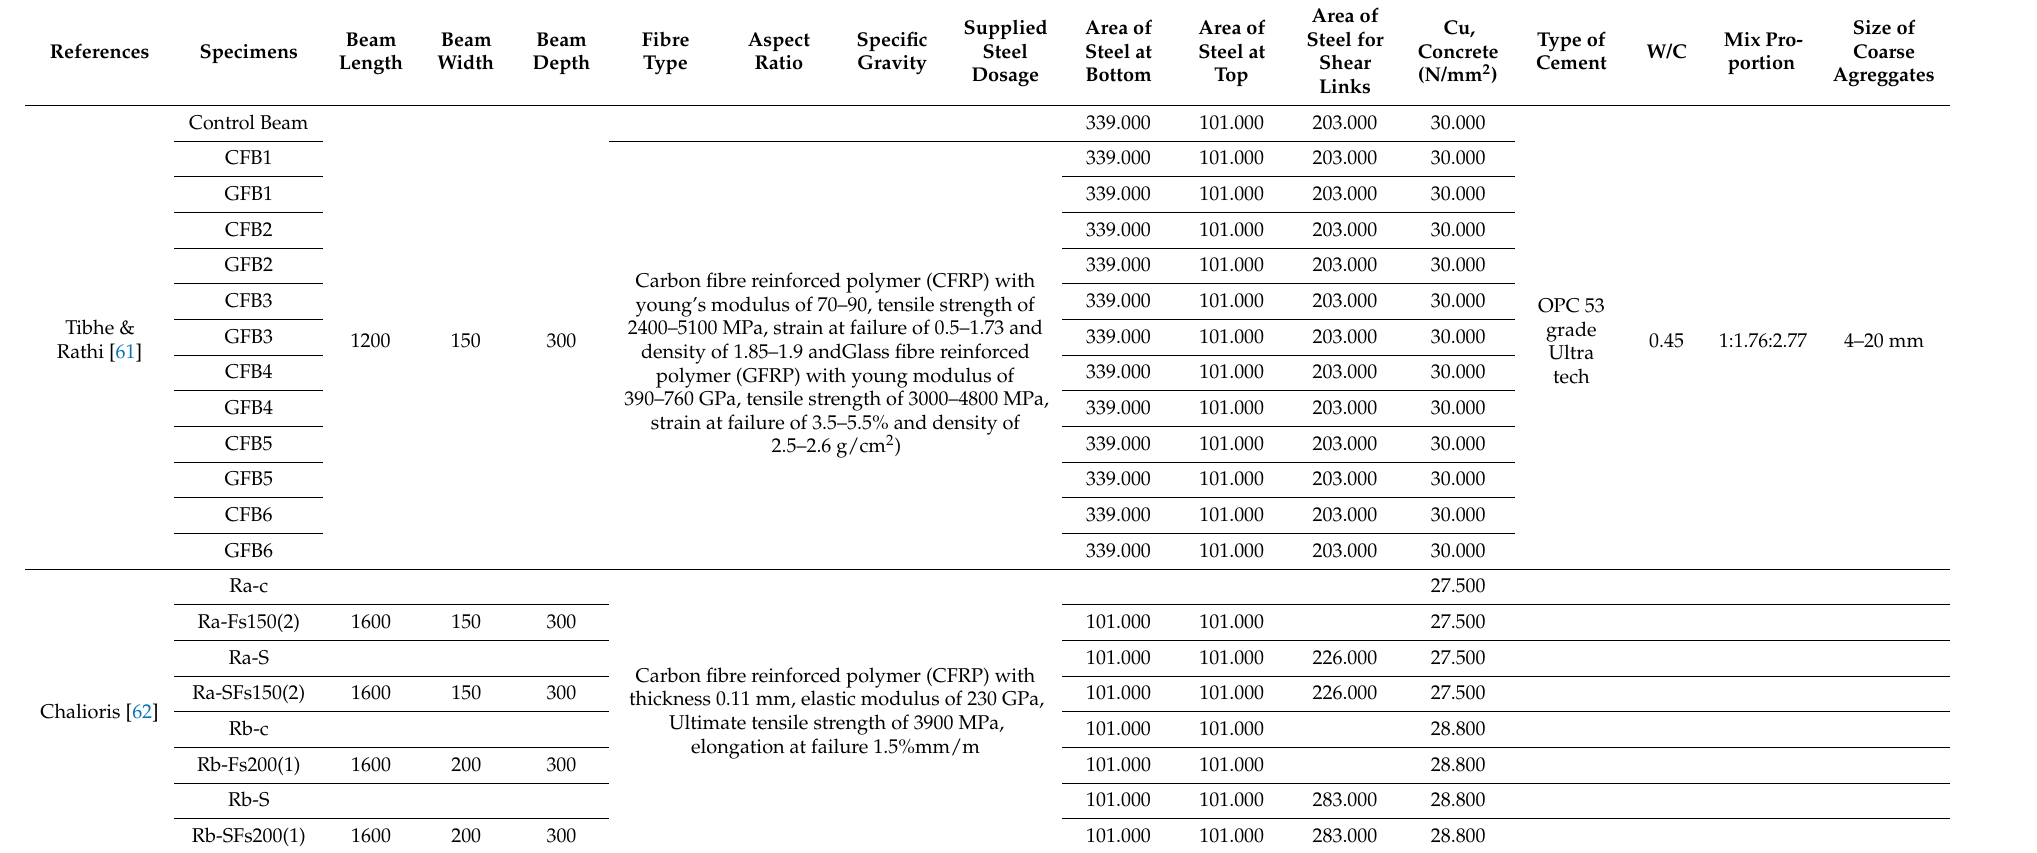
Table 5. Methods of preparation of carbon fibre reinforced concrete from previous